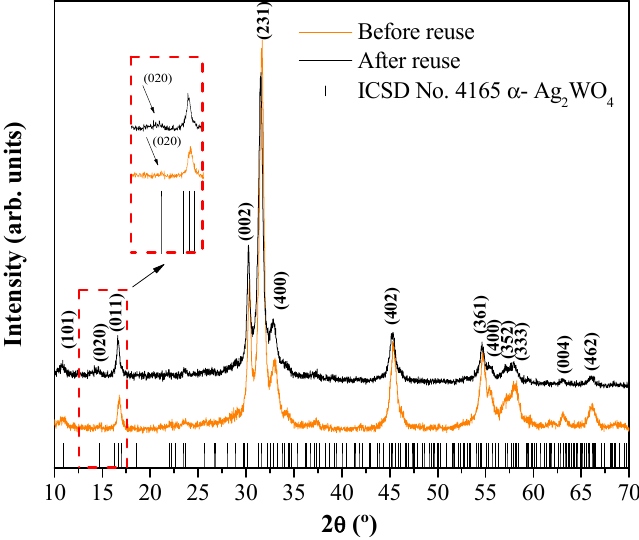
Figure 8. XRD of α -Ag 2 WO 4 -CA before and after its use in the degradation of RhB. The vertical lines indicate the respective positions of α -Ag 2 WO 4 found on the ICSD card 4165.